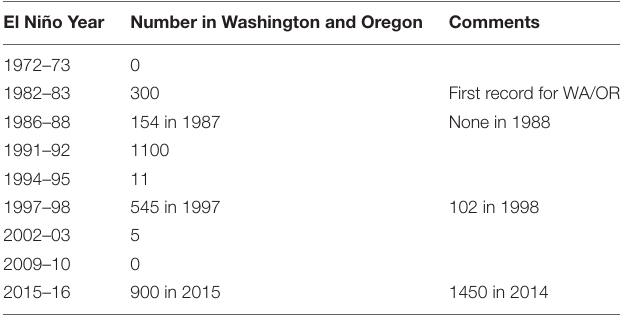
TABLE 1 | Occurrence of elegant terns in Washington and Oregon during El Niño